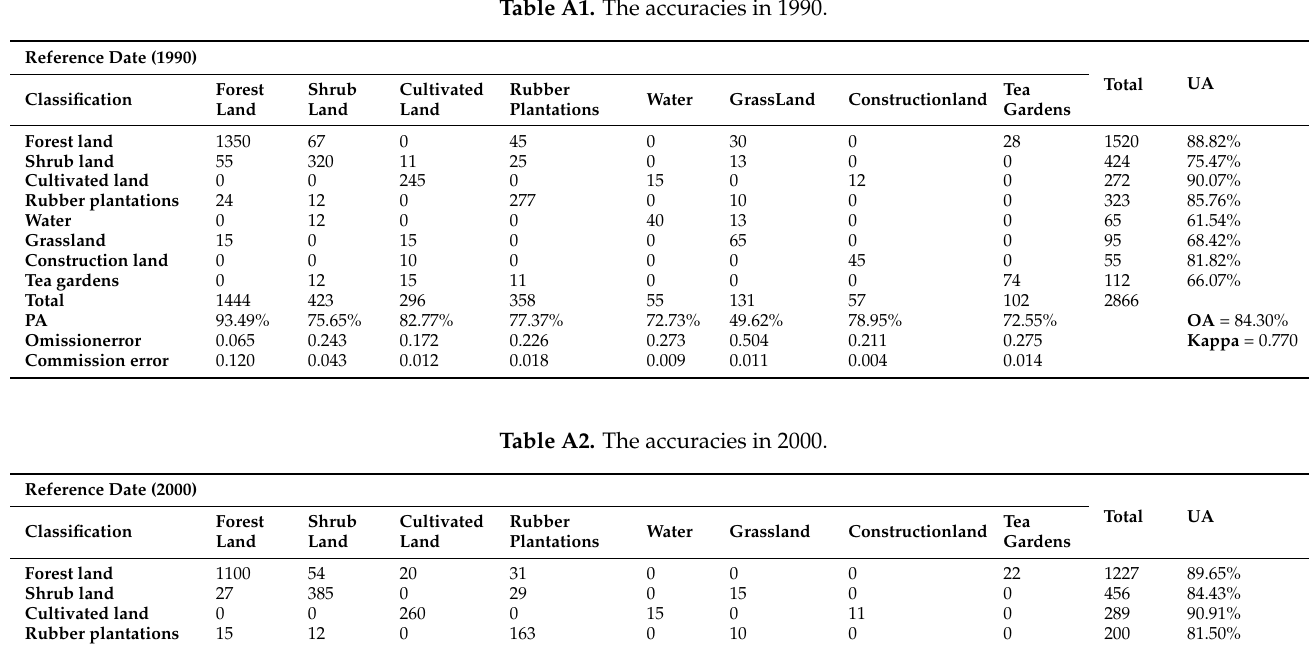
Table A1. The accuracies in 1990.